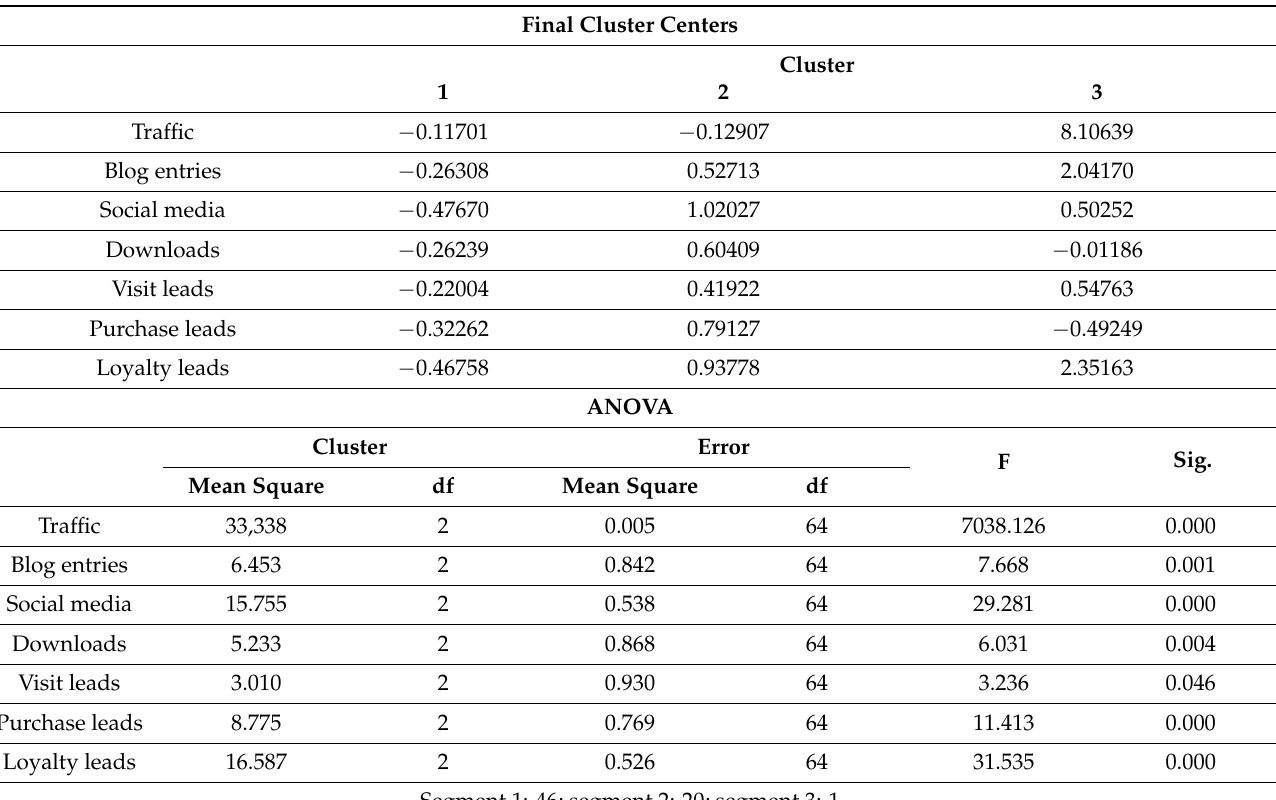
Table 5. K means analysis and segmentation results of the Canary Islands’ museums